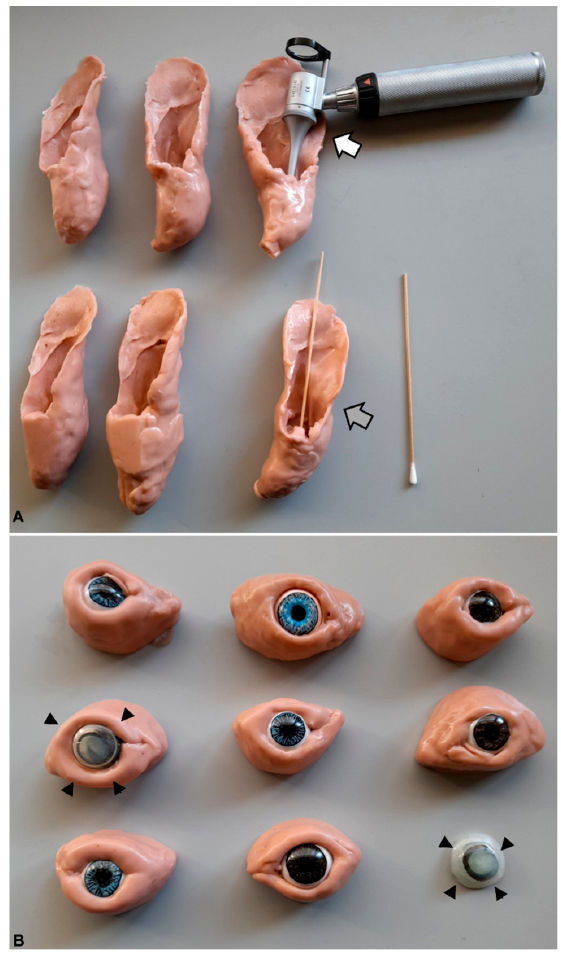
Figure 1. Ear ( A ) and eye ( B ) models made with moldable silicone. The ear models are at scale (medium sized dog) and allowed otoscopy (white arrow) and ear cytology (grey arrow) procedures. The eye models included the eye and eyelids; the corneas could be changed to represent various clinical conditions, such as corneal edema (arrowheads).